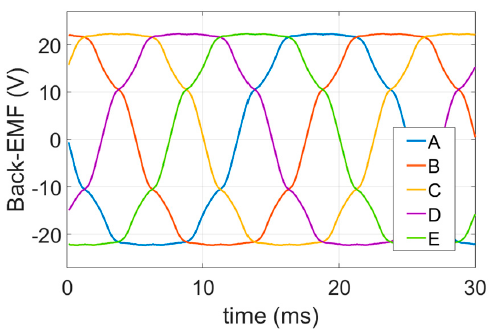
Figure 2. Back-EMF waveform of the simulated five-phase PM machine “Reprinted from Publisher, 2021 [44]”.